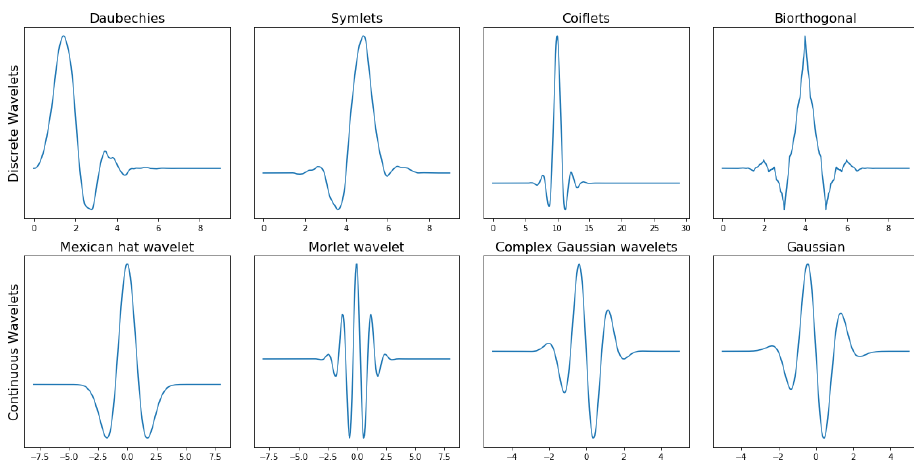
Figure 1. Comparison between different signal representations.